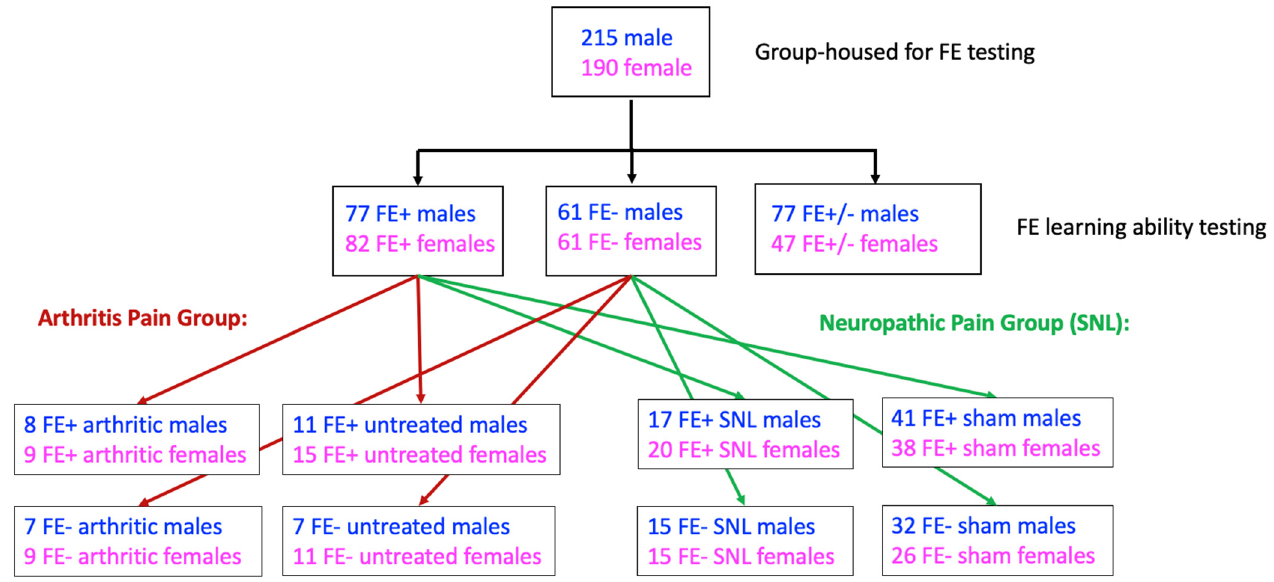
Figure 1. Experimental design. Rats underwent fear conditioning and extinction learning protocols before being separated into FE+ and FE − groups for either the acute arthritis pain (vs. untreated control) groups or the chronic neuropathic pain (vs. sham control) groups. FE: fear extinction.